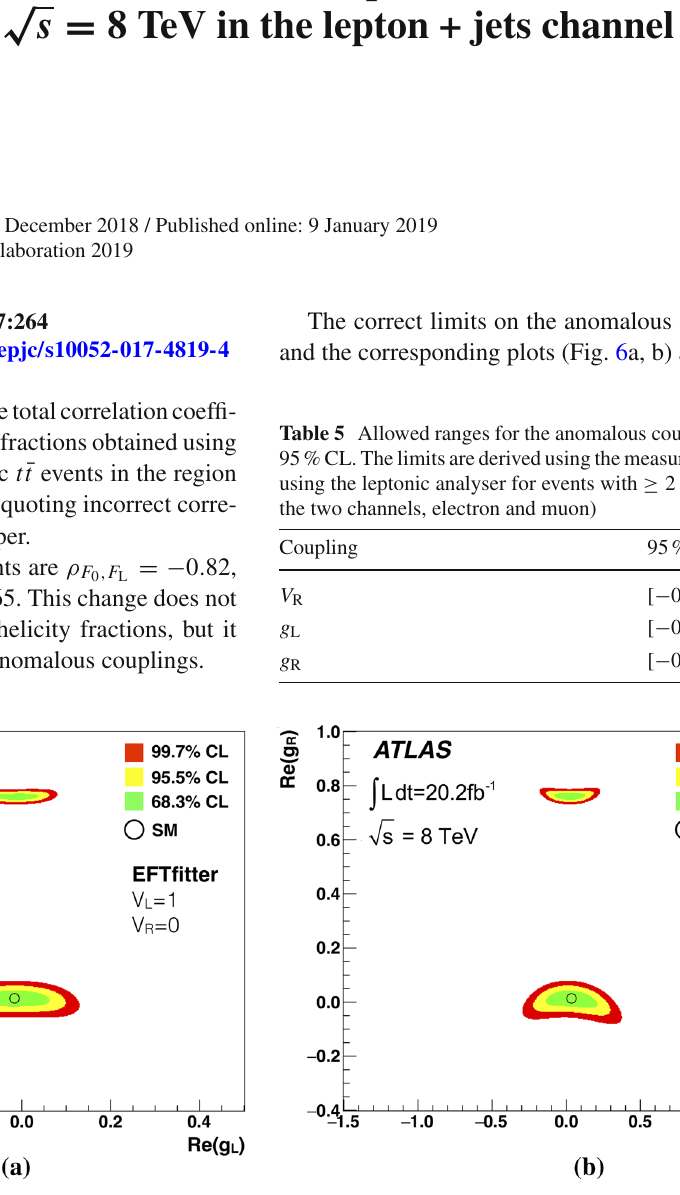
Fig. 6 a Limits on the anomalous left- and right-handed tensor couplings of the Wtb decay vertex as obtained from the measured W boson helicity fractions from the leptonic analyser. b Limits on the right-handed vector and tensor coupling. As the couplings are assumed to be real, the real part corresponds to the magnitude. Unconsidered couplings are fixed to their SM values